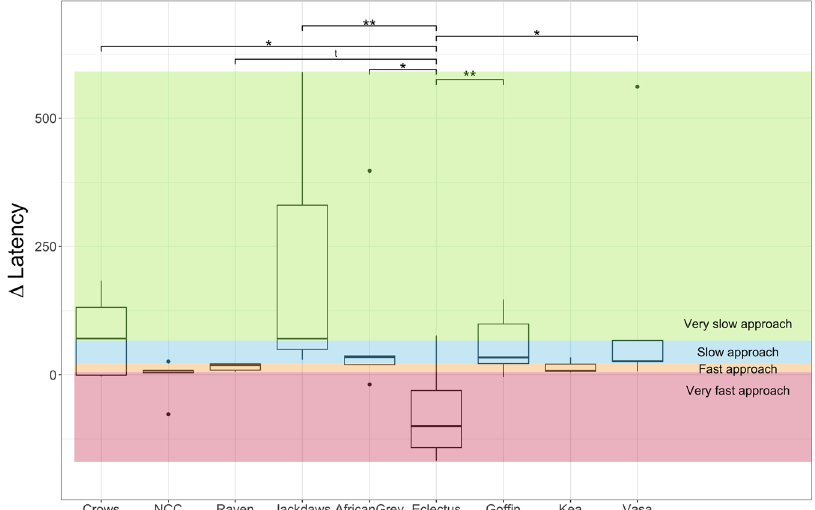
Figure 2. Delta latencies (approach latency in the last, non-consecutive session subtracted from the approach time in the first trial of session one) for all species; bold horizontal lines indicate median values, boxes span the first to third quartiles and whiskers represent 95% confidence intervals; horizontal lines indicate species comparisons; Significance codes: ‘ *** ’ for p < 0.001, ‘ ** ’ for p < 0.01, ‘ * ’ for p < 0.05, ‘t’ for p < 0.1 (alpha adjusted for multiple